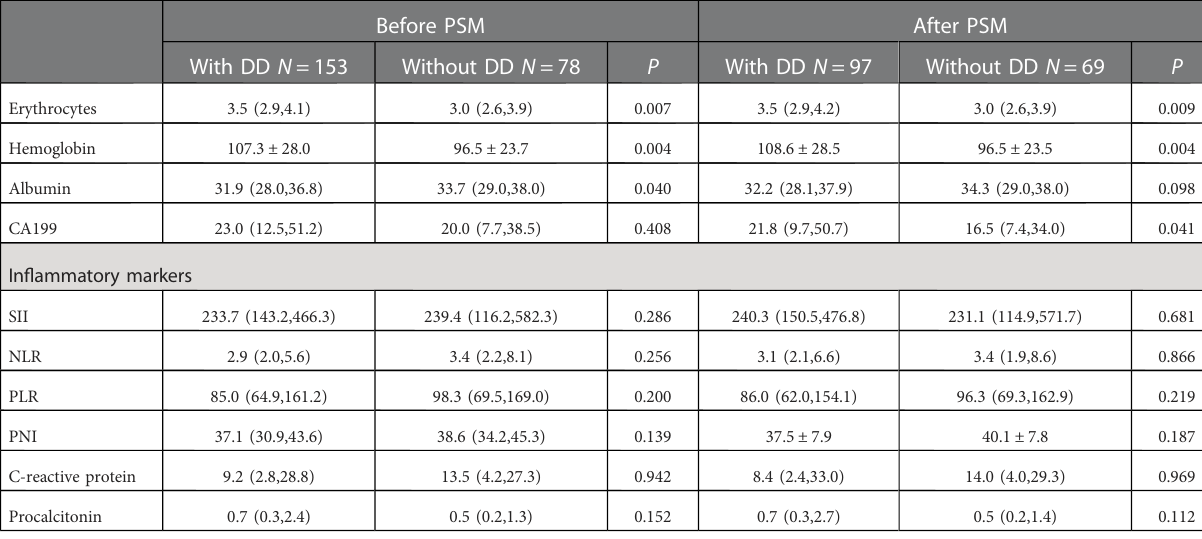
TABLE 2 Comparisons of routine laboratory test results and in fl ammatory markers between patients with and without DD. Before PSM